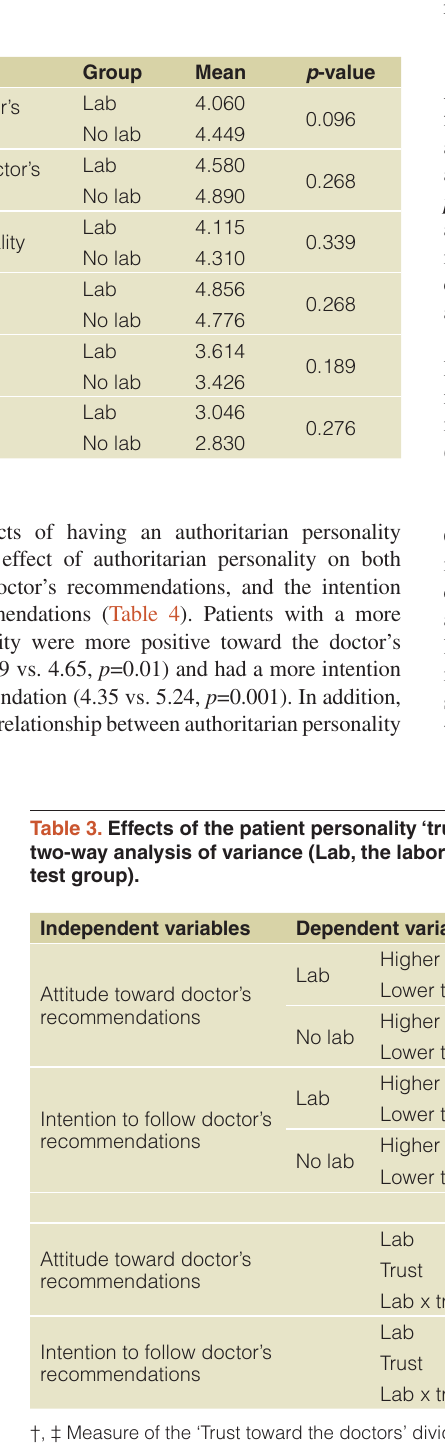
Table 2. Comparison between groups: results of the unpaired t -test (Lab, the laboratory test group; No Lab, no laboratory test group).